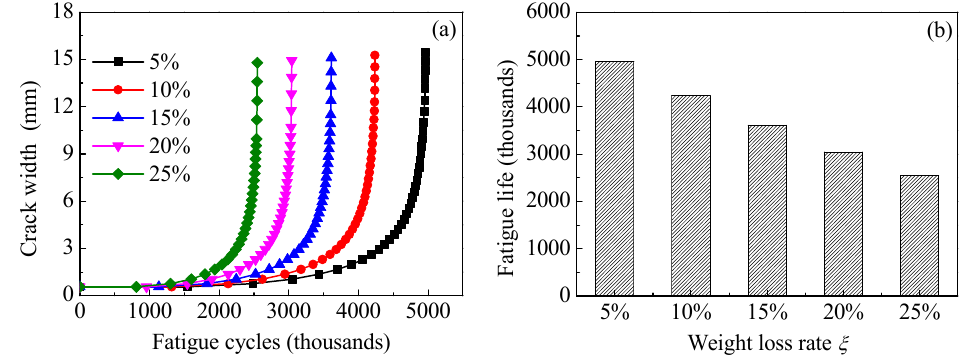
a and ( b ) K c vs. crack i